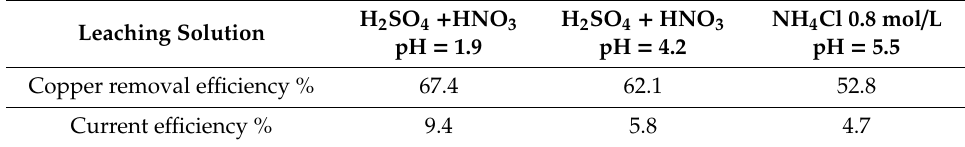
Table 3. Copper removal efficiency and current efficiency after electrodialytic treatment according to leaching solution.